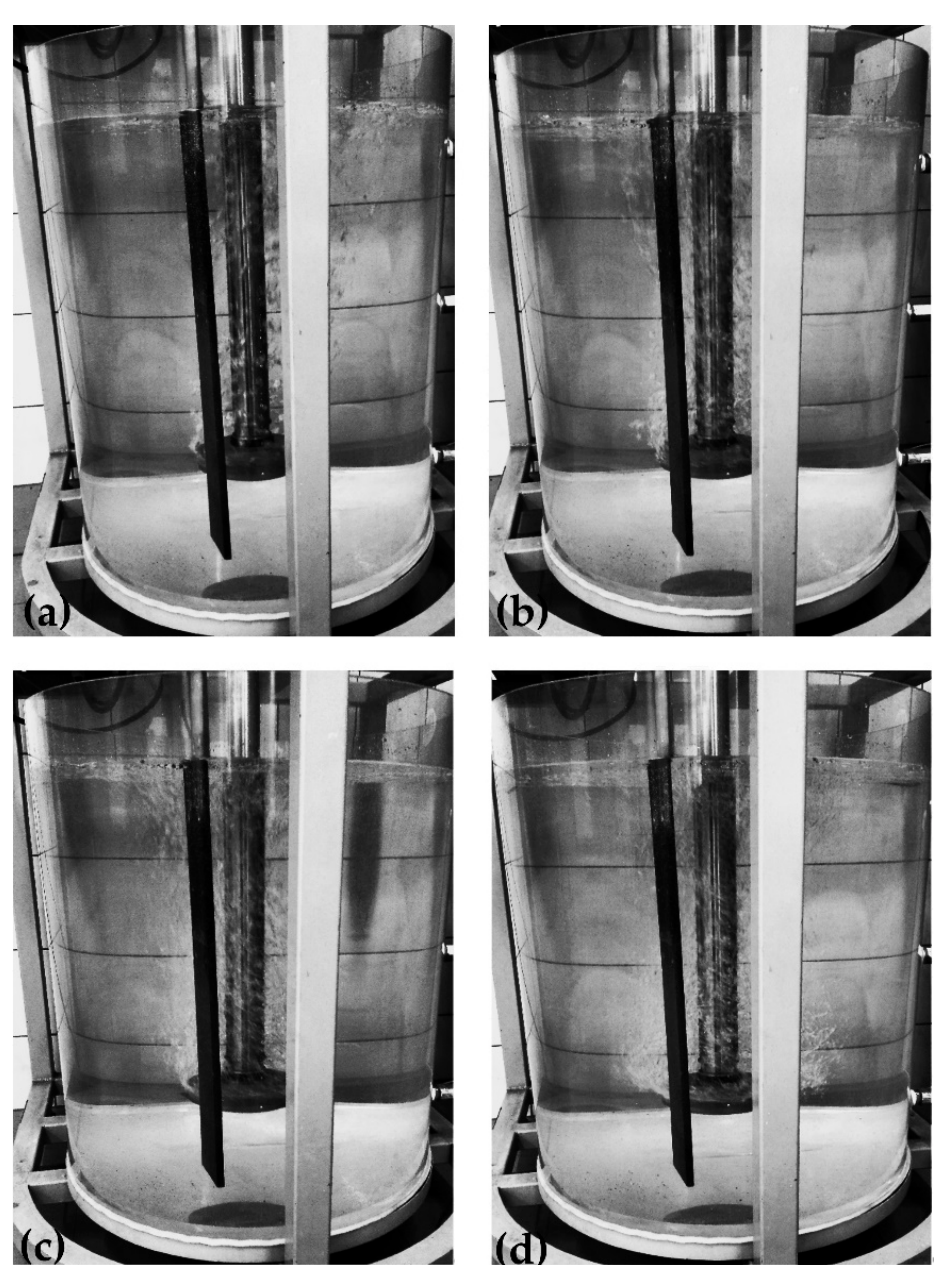
Figure 12. Impeller variant B8—gas bubbles dispersion registered for a gas flow rate of 10 dm 3 ⋅ min − 1 and rotor speed of ( a ) 200, ( b ) 300, ( c ) 400, and ( d ) 500 rpm. and rotor speed of ( a ) 200, ( b ) 300, ( c ) 400, and ( d ) 500